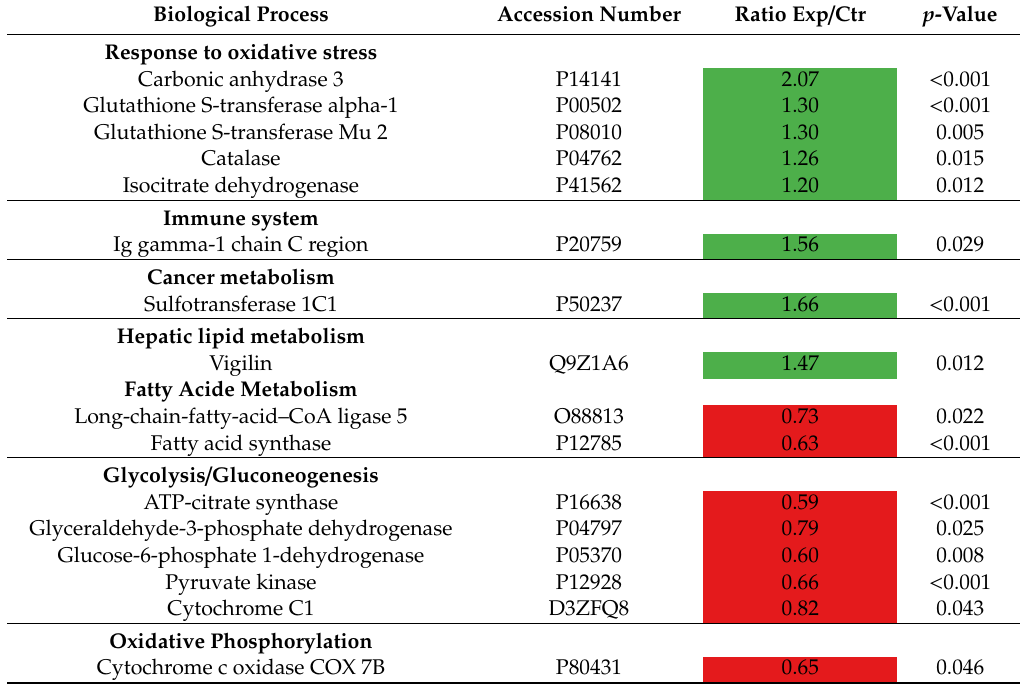
Table 5. Examples of dysregulated proteins in the liver following exposure to iron NPs and the corresponding biological processes. The data were generated from TargetMine software: Biological process name, protein name, protein accession number, ratio exposed (Exp) / control (Ctr), p -value ratio. Up-regulated proteins are highlighted in green color and down-regulated proteins in red